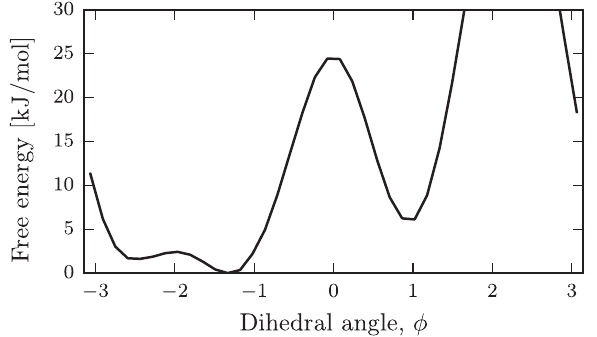
FIG. 8. Free-energy profile for alanine dipeptide as a function of the ϕ dihedral angle. One can identify three metastable sets: two low-energy (high-probability) sets with ϕ < 0 and a single high-energy (low-probability) set with ϕ > 0 .